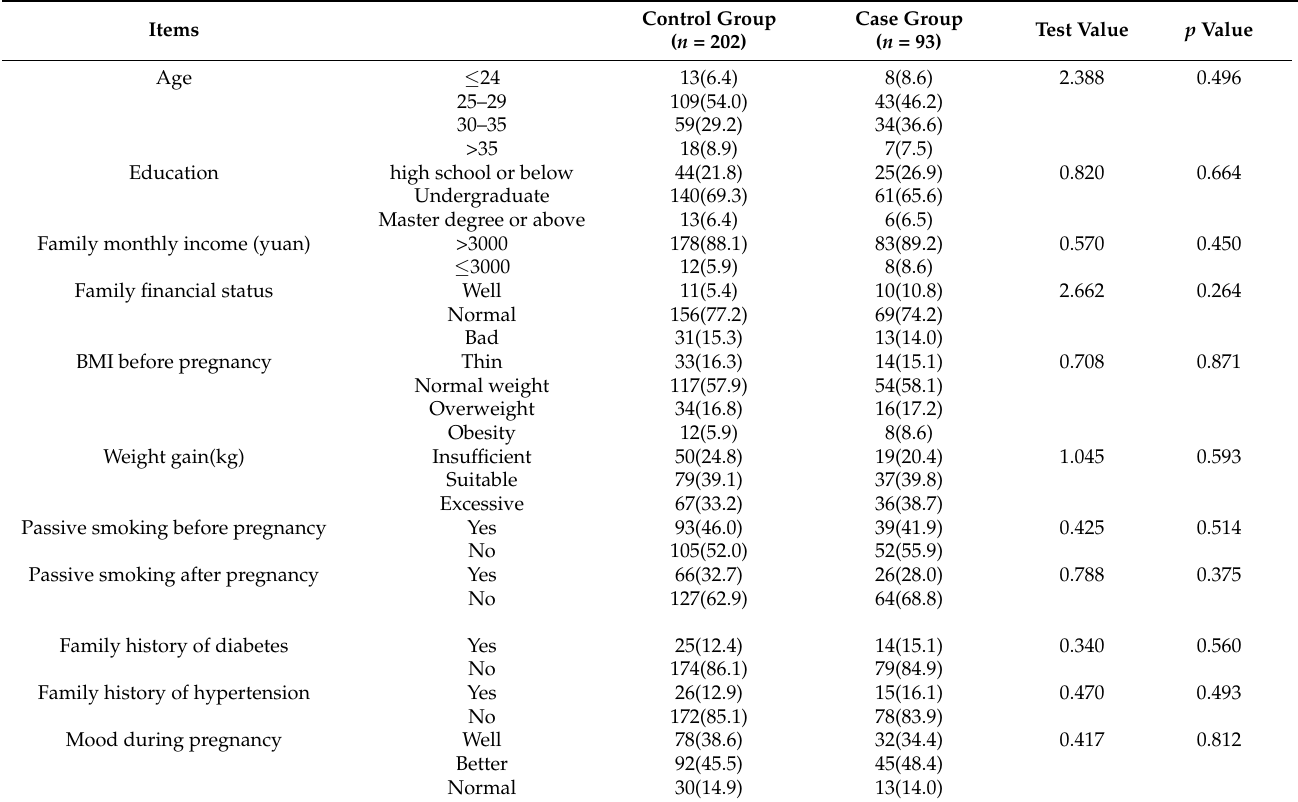
Figure 2. Correlation between leptin in cord blood and the birth weight. Compared with the control group, the proportion of pregnant women whose age was higher than 30 years old, family financial status was well, or weight gain was excessive during pregnancy was higher in the case group (44.1% vs. 38.1%; 10.8% vs. 5.4%; 38.7% vs. 33.2%, respectively), and the proportion of passive smoking before or after pregnancy was lower in the case group (41.9% vs. 46.0%; 28.0% vs. 32.7%, respectively). None of the differences above were statistically significant ( p > 0.05). There was no significant difference in the proportion of pregnant women with family history of diabetes or hypertension between the control group and the case group ( p > 0.05), shown in Table 5. Table 5. Comparison of the basic situation of pregnant women in the control and case groups ( n , %).